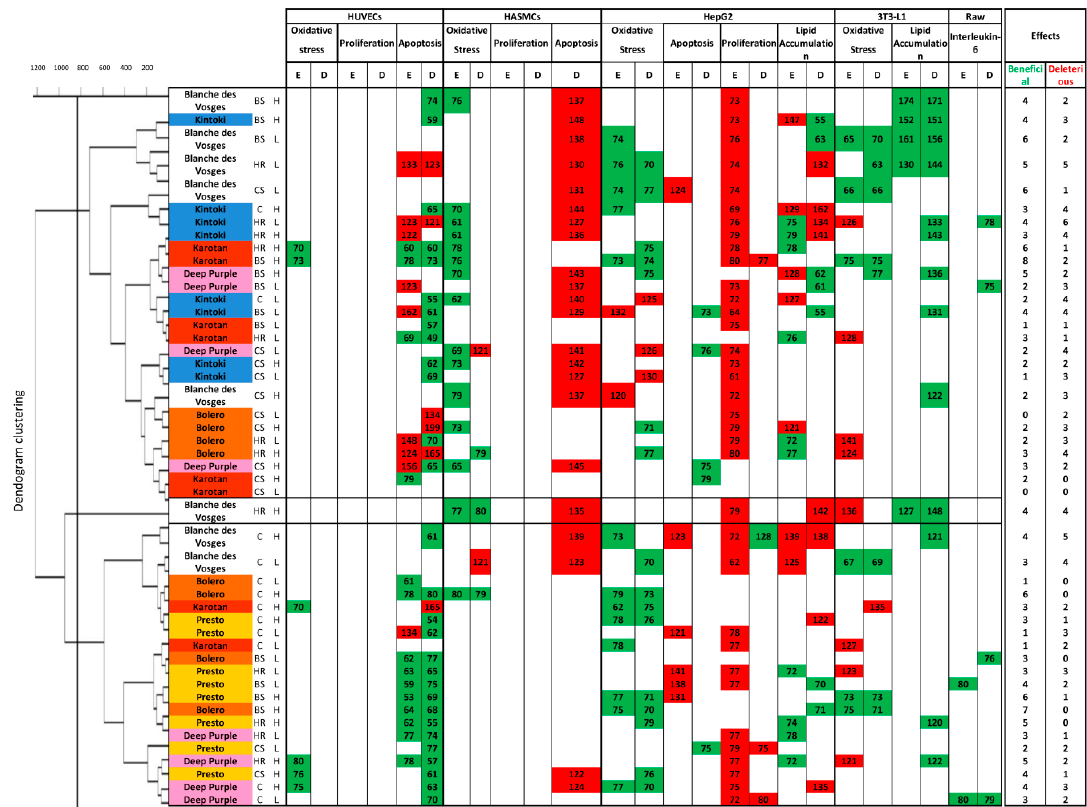
Figure 5. Hierarchical clustering of carrot samples generated from cell pharmacological responses. Cluster dendogram and table showing results obtained in cell models, grouped following clustering. Green cells indicate beneficial effect; red cells correspond to deleterious effect; while white cells show insignificant biological effect.